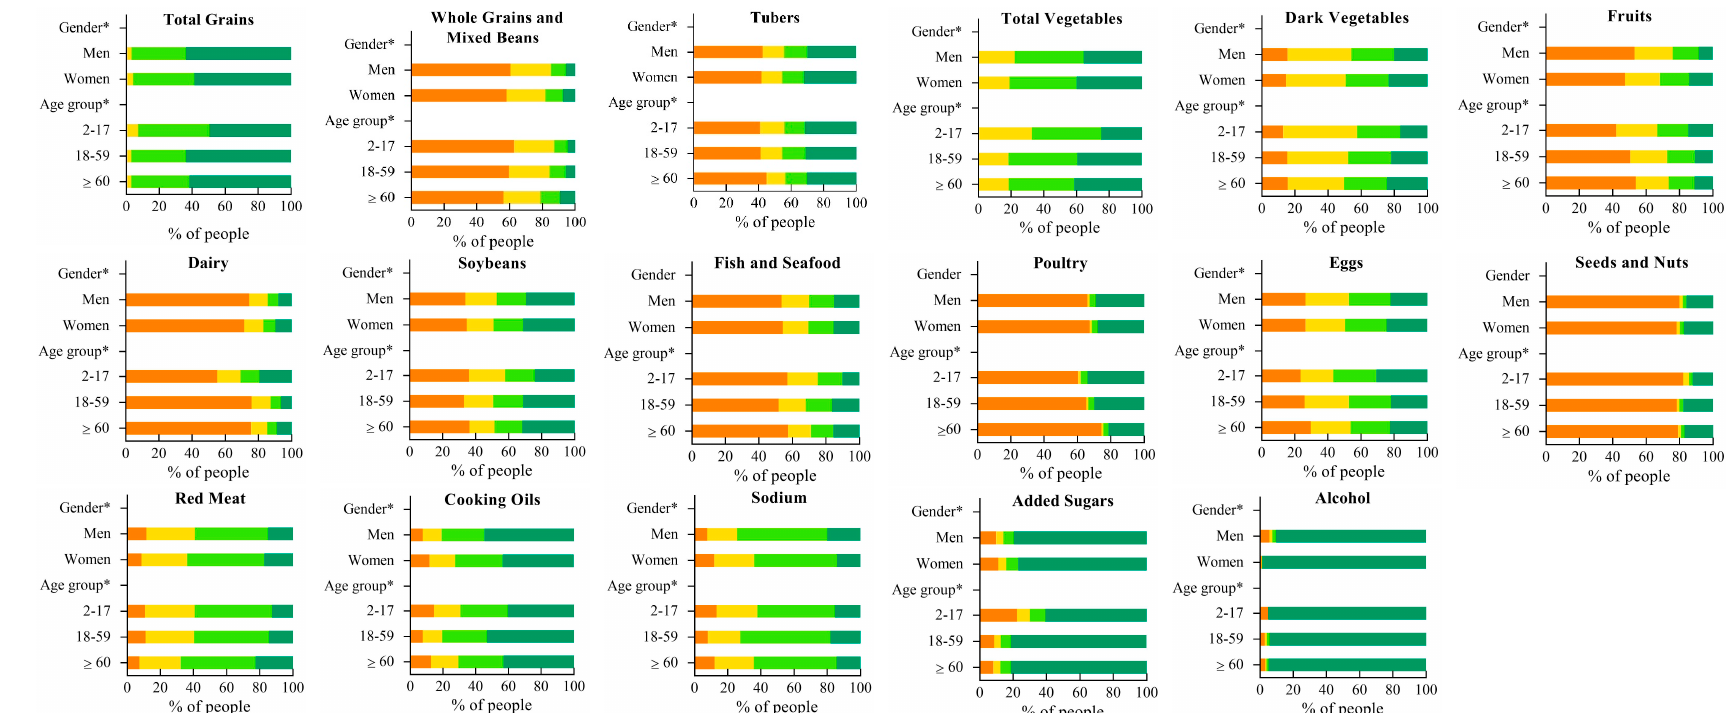
Figure 1. Proportion of participants in four section scores of the 17 CHEI components, according to the sex and age groups (years). For all components except fruits, sodium and cooking oils, the four sections are 0 , (0–2.5) , [2.5–5) , 5 . For fruits, sodium and cooking oils, the four sections are 0 , (0–5) , [5–10) , 10 . * Significant differences in four section scores of the 17 CHEI components between sex or age groups ( χ 2 test): p < 0.05.